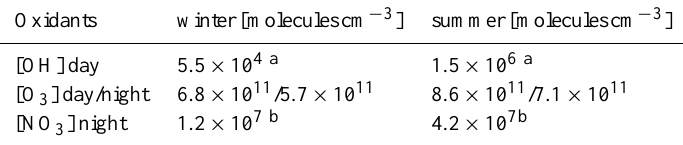
Table 2. Concentrations of hydroxyl (OH), ozone (O 3 ), and nitrate radicals (NO 3 ) used in the lifetime calculations of the VOCs. Oxidants